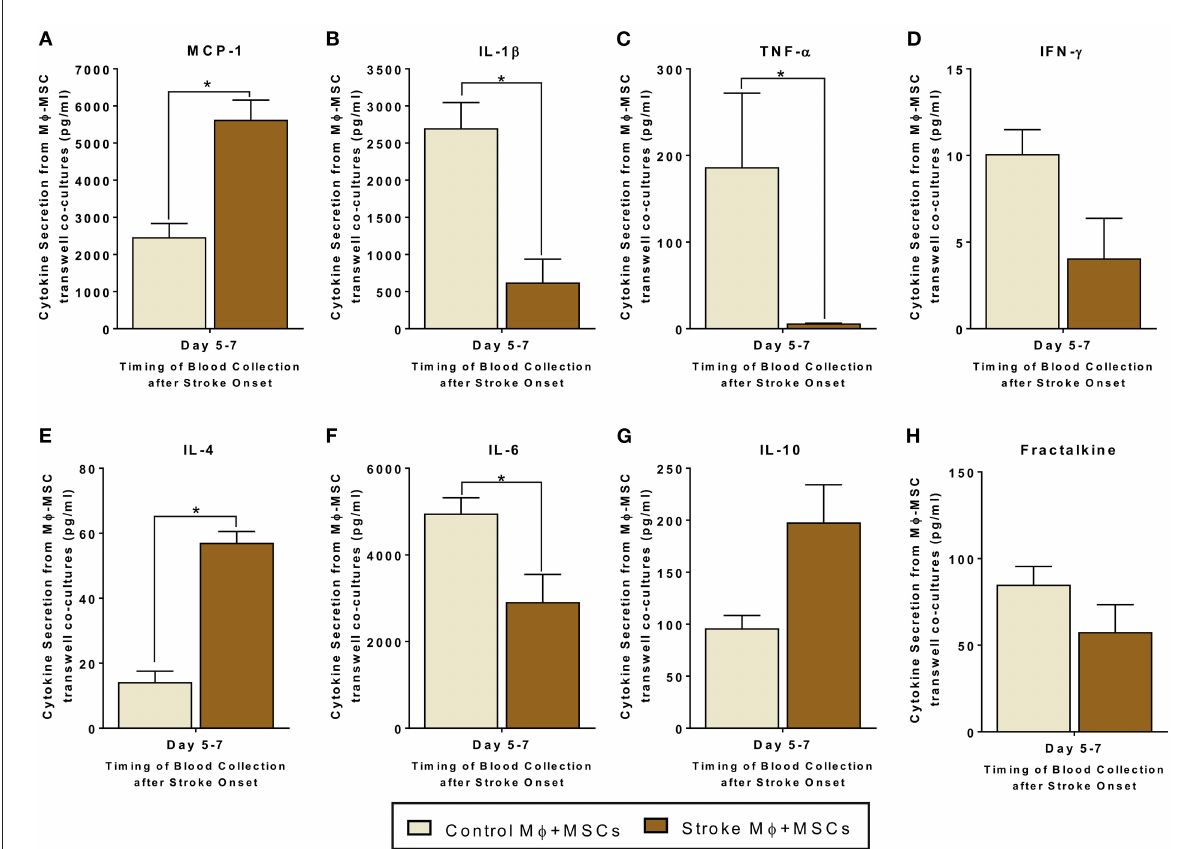
FIGURE2 Secretomes released from trans-well co-cultures of peripheral blood monocytes (M φ ) and human bone marrow derived mesenchymal stromal cells (MSCs). (A–H) represents secretions of MCP-1, IL-1 β , TNF- α , IFN- γ , IL-4, IL-6, IL-10, and Fractalkine. Monocytes are isolated from peripheral blood of healthy controls and stroke patients, and cultured with MSCs for 24h ( N = 5, error bars represent SEM, * p <